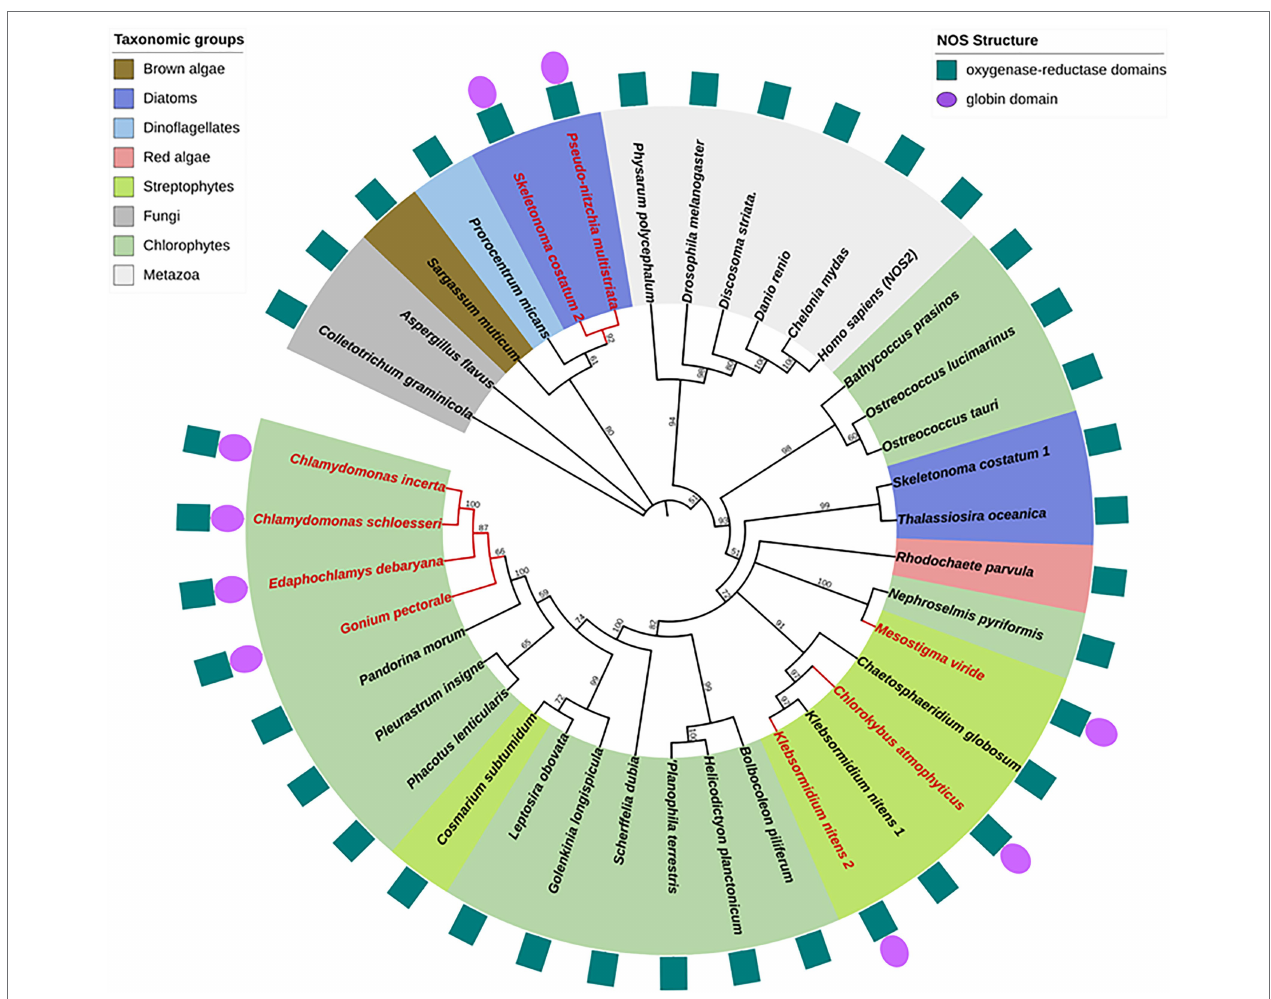
FIGURE 3 | Phylogenetic reconstruction of NOS proteins. Algal NOS sequences were extracted from databases (see Santolini et al., 2017). NOS proteins were aligned with ClustalW and the phylogenetic tree was constructed by maximum likelihood method using MEGA (Tamura et al., 2021). Bootstrap analysis was carried out using 500 replicates. All nodes with bootstrap values less than 50% were collapsed into polytomies. Branches and labels in red indicate chimeric structures. Protein domain organization is depicted around the phylogenetic